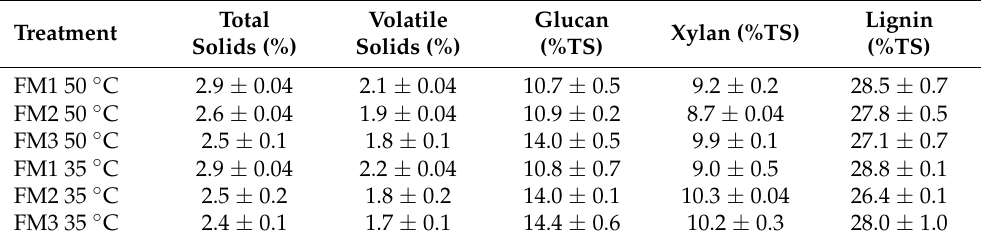
Table 3. Fiber composition of the digestate at the end of the experiment. Treatment